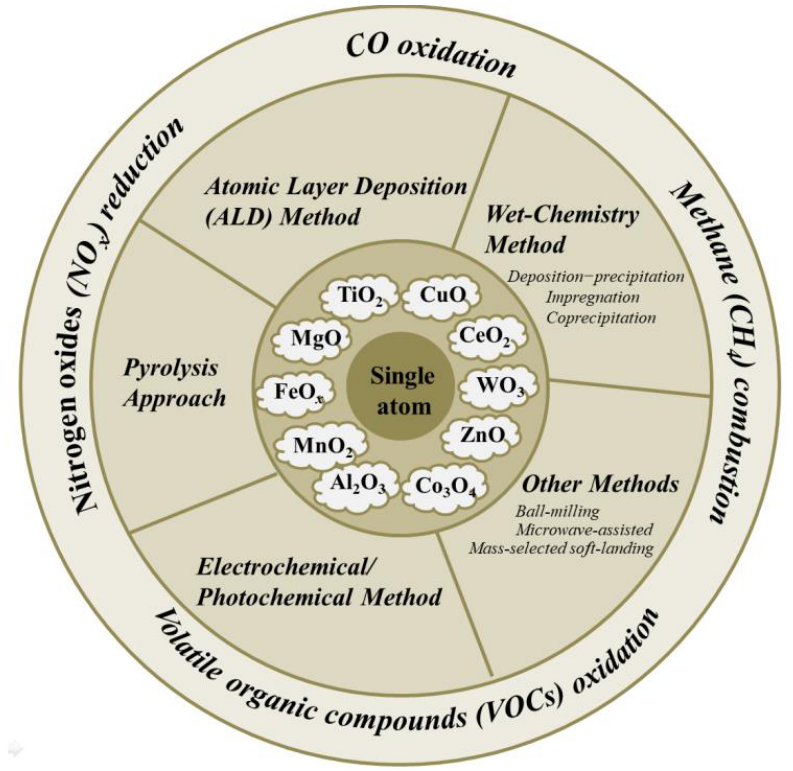
Figure 1. Supports, preparation strategies, and applications of SACs in environmental catalysis.